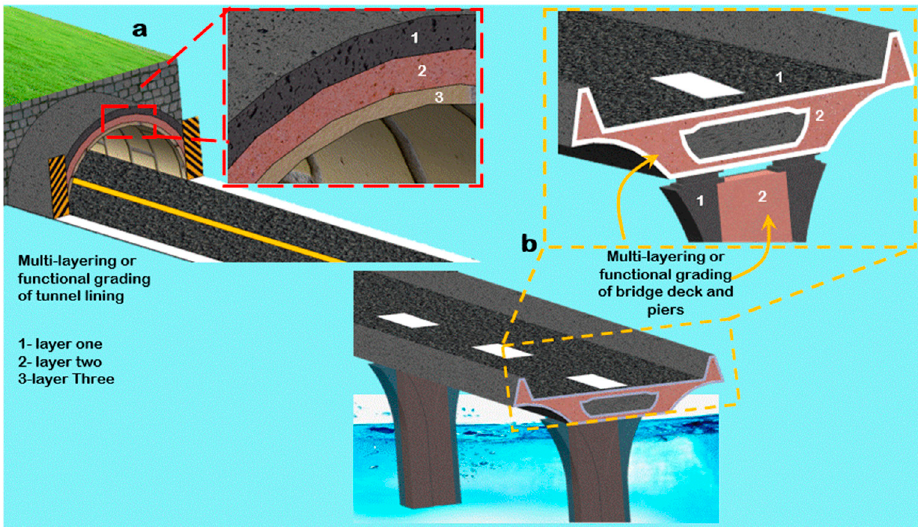
Figure 6. Conceptualization of the application of multilayering to ( a ) tunnels and ( b ) bridges .